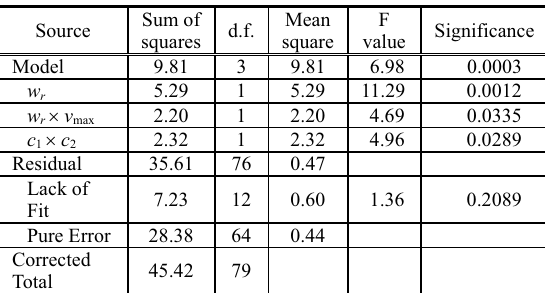
Table 8. ANOVA for experiment on PSO parameters.